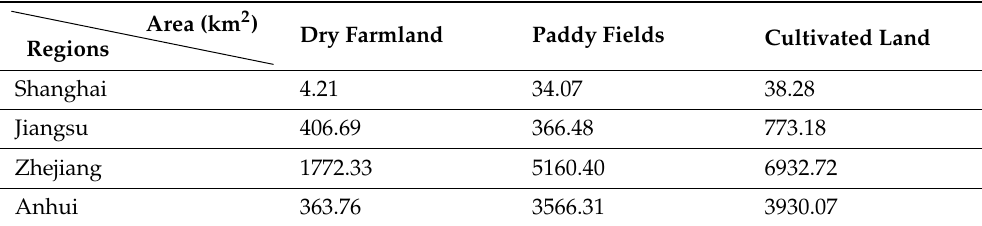
Table 4. The increased area of cultivated land in the Yangtze River Delta after the implementation of the land returning